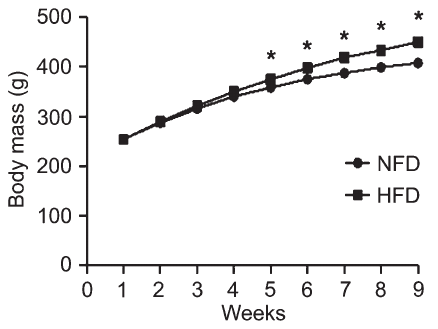
Figure 1. Body mass of normal fat diet (NFD; n=16) and high-fat diet (HFD; n=71) groups during obesity-induction period. *P , 0.05 vs NFD (Student t